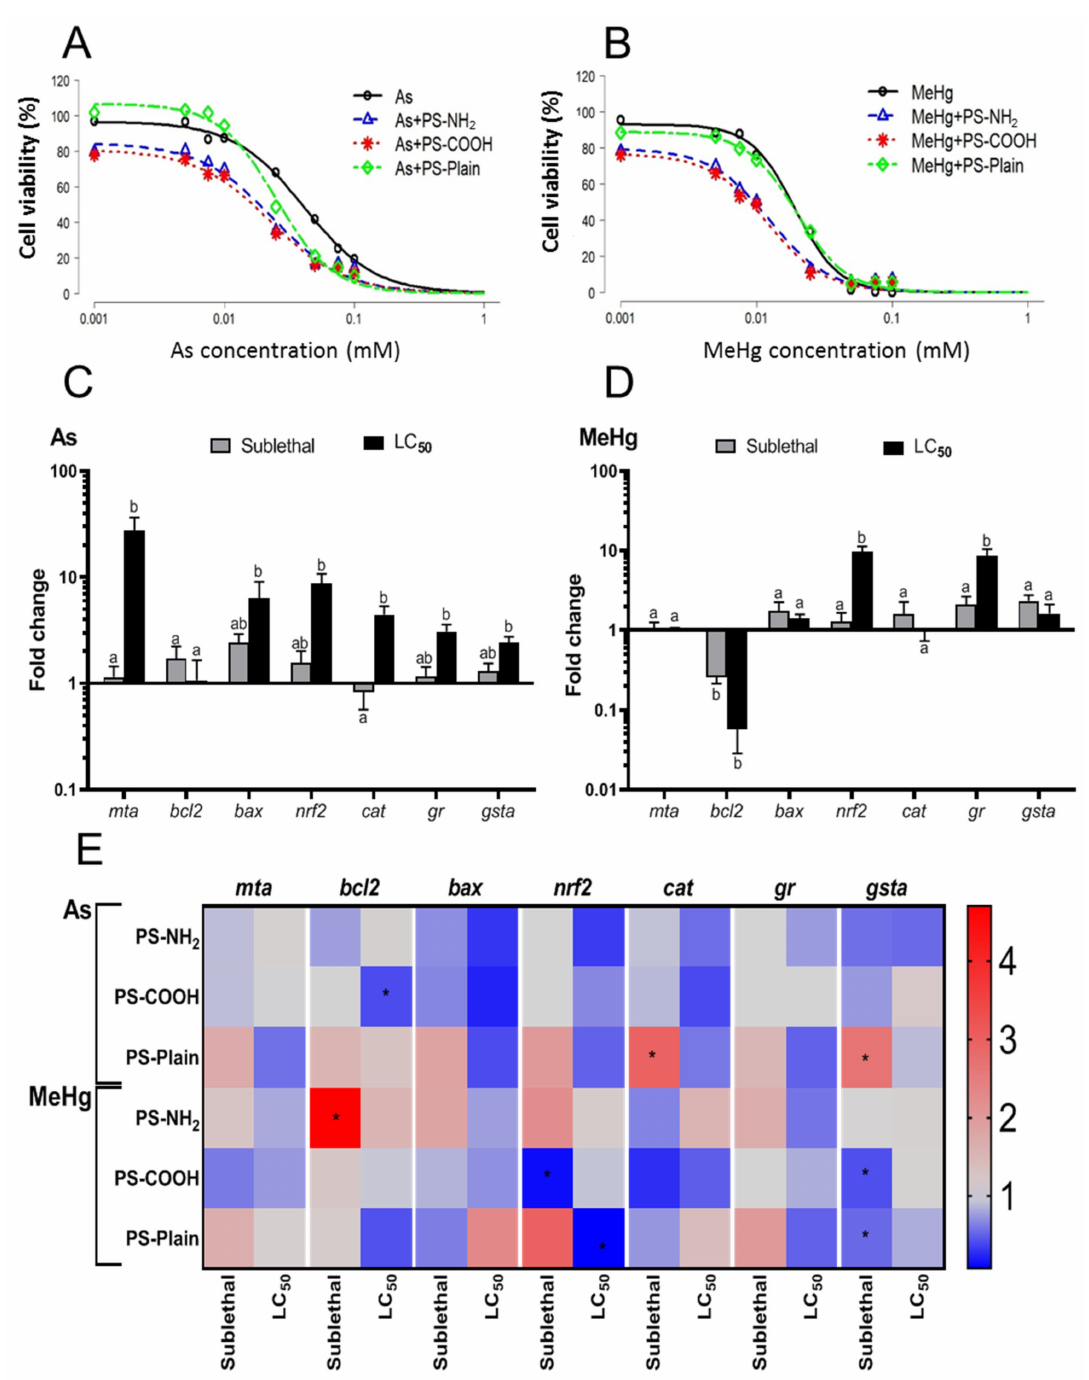
Figure 4. Combined effects and interactions between functionalized NPs and metals As and MeHg. Cytotoxicity curves of SaB-1 cells exposed to metals As ( A ) and MeHg ( B ) alone or in combination with 1 µ g mL − 1 of functionalized polystyrene nanoplastics (PS-NH 2 , PS-COOH and PS-Plain) for 24 h. Percent of cell viability ( n = 3) is calculated as a percentage of the control or unexposed cells while lines are the fitted curves. The transcriptional profile of SaB-1 cells exposed to sublethal (grey bars) or LC 50 (black bars) dosages of metals As ( C ) and MeHg ( D ) alone for 24 h. Data are presented as mean